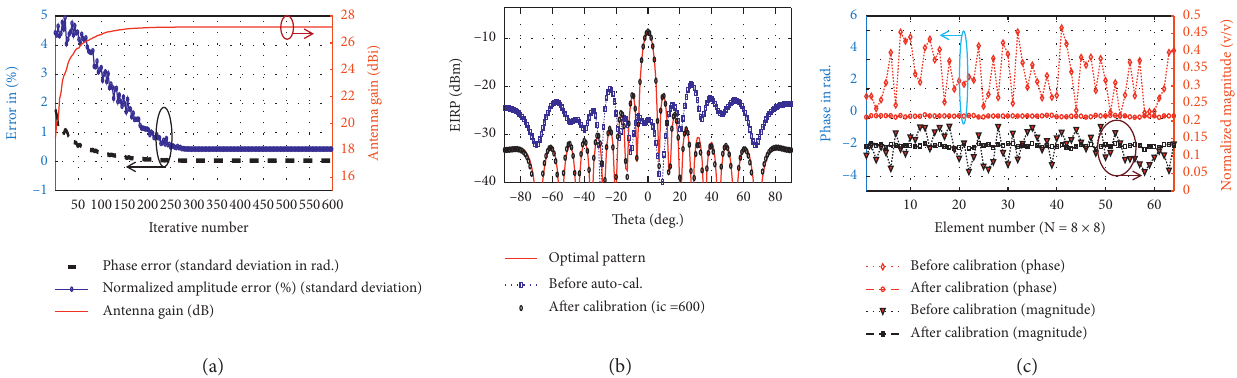
Figure 3: (a) Convergence analysis results regarding antenna gain and error of W against an iterative sequence number. (b) Simulated far-field patterns obtained after the use of GA ( M � 20000 and I e � 600). (c) Corresponding phase and normalized magnitude of the weighting vector ( W ) used in EIRP computation.